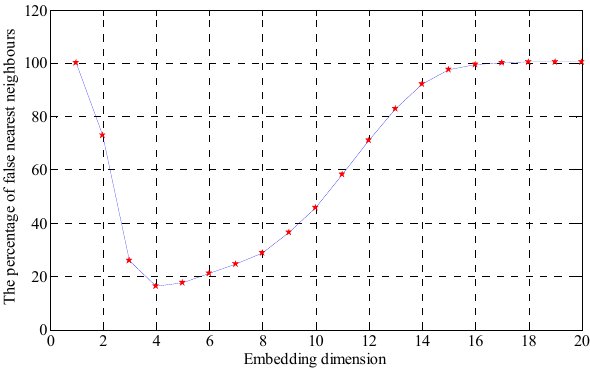
Figure 10. Embedded dimension by the false nearest neighbor point method.